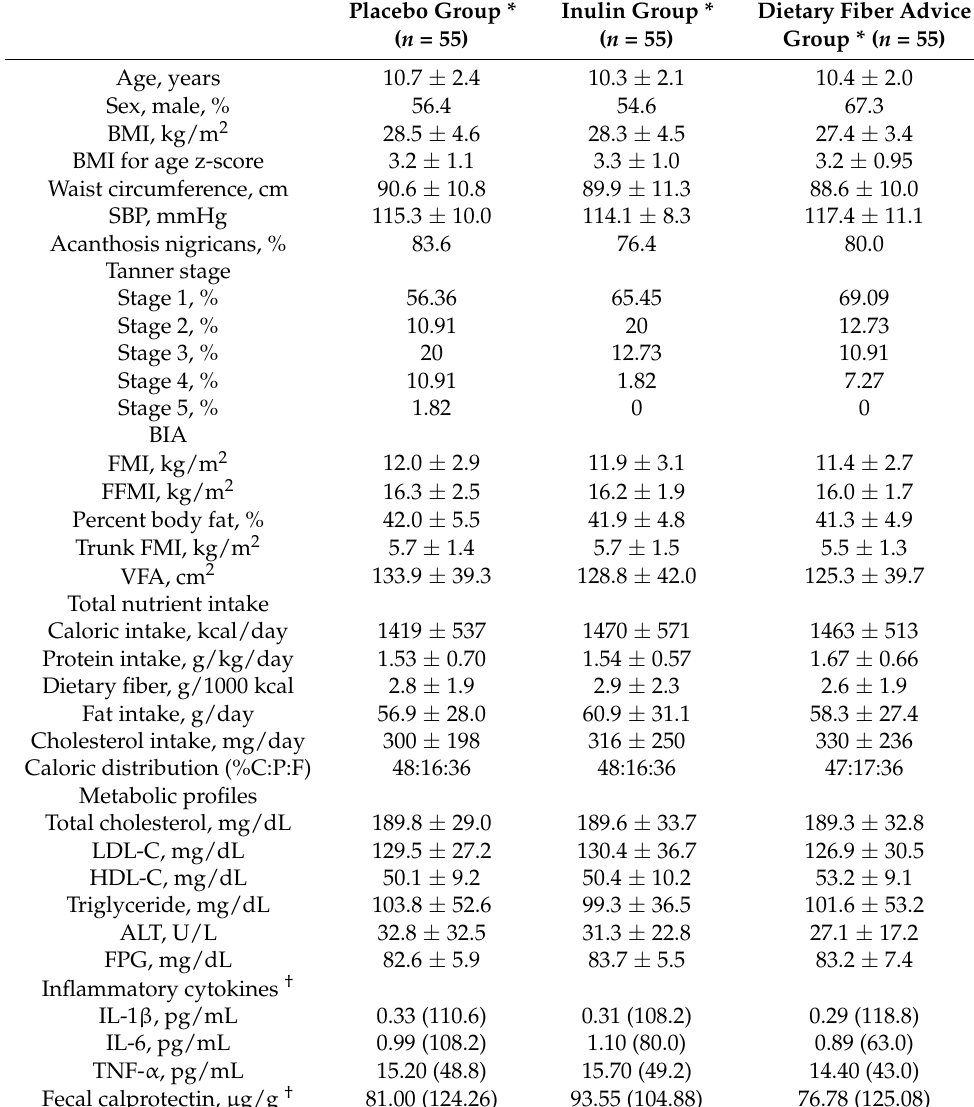
Table 1. Baseline characteristics of obese children at the first visit ( n =